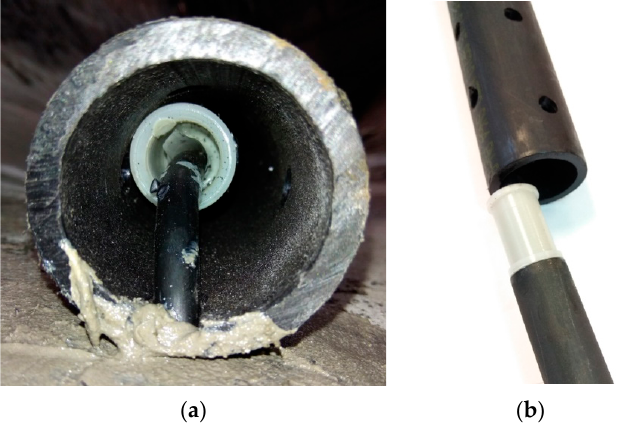
Figure 7. ( a ) View of the Ti/MMO anode installed on the bottom of the classifier tank, ( b ) view of the anode tip and protective tube before installation.